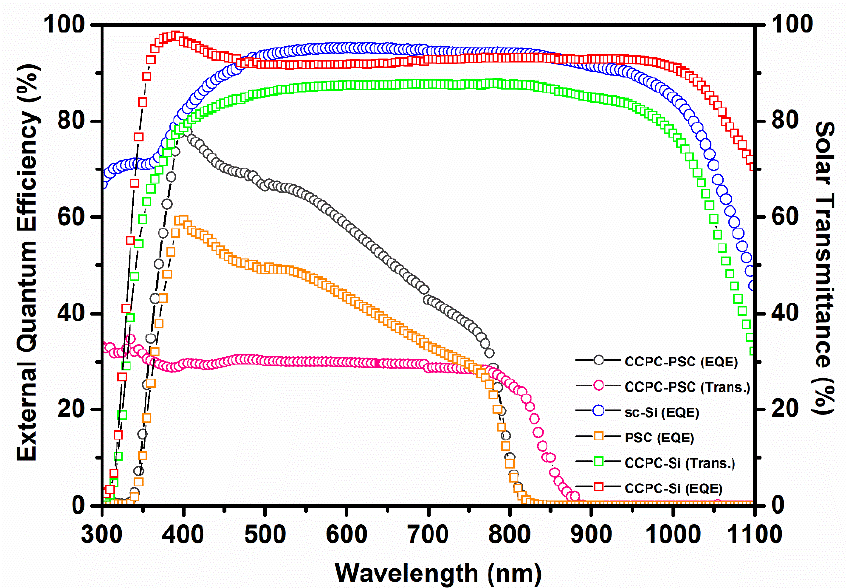
Figure 4. The plot of the external quantum efficiency (EQE) and solar transmission variation for PSC and CCPC-integrated-PSC devices compared with single crystalline silicon solar cells consisting of a similar active area of 1 cm 2 .